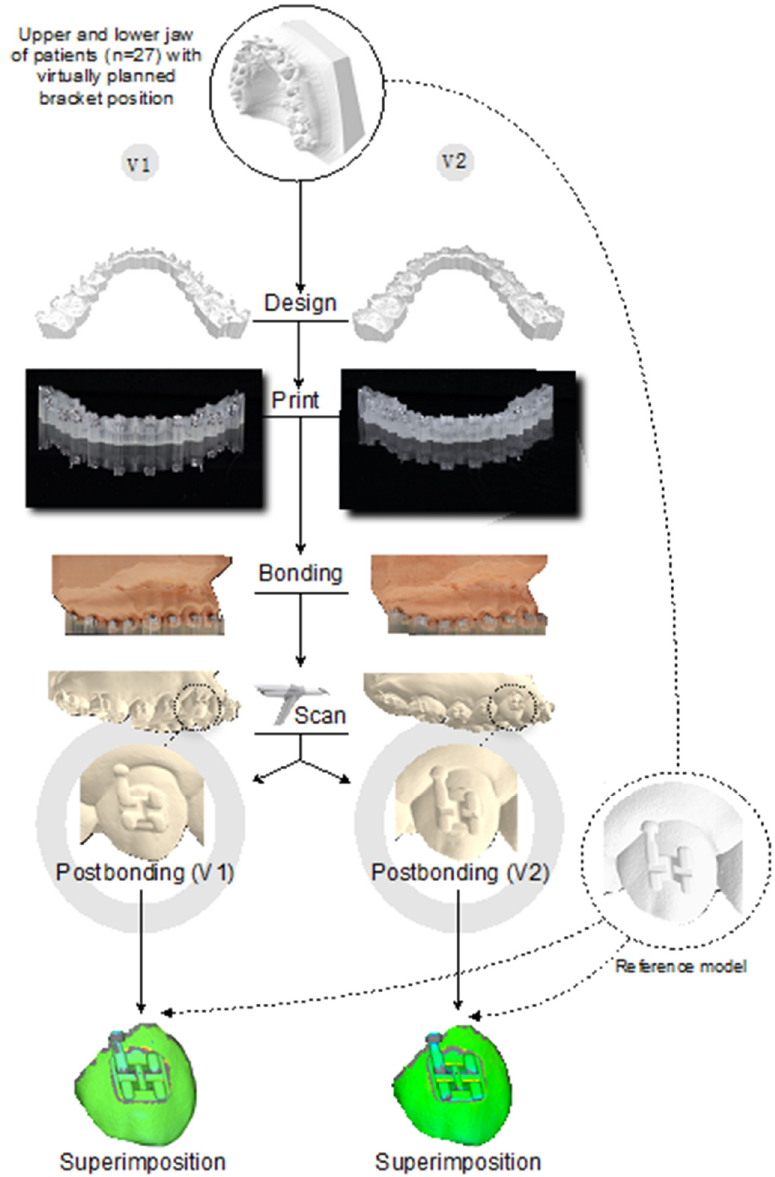
Figure 1. Flow Figure 1. Flow chart.